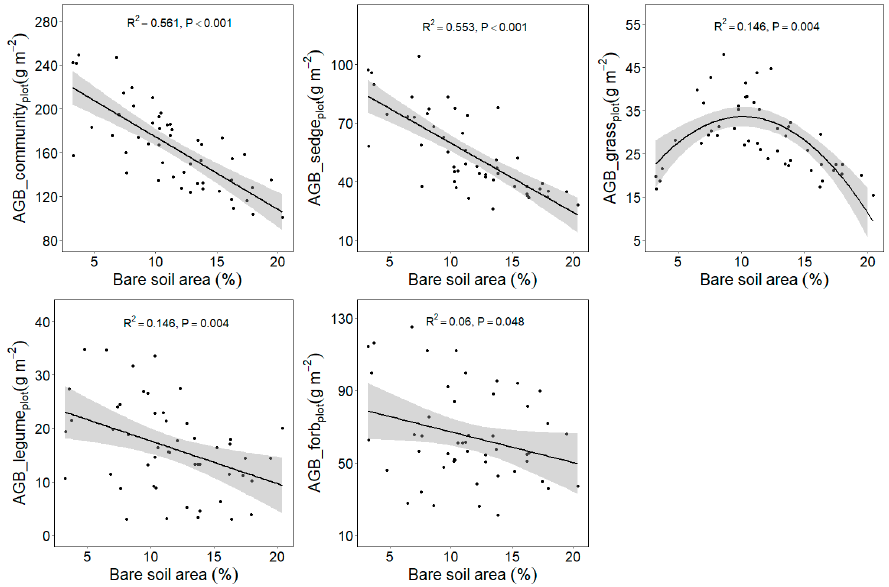
Figure 4. Relationship between plant aboveground biomass at plot scale and the bare soil area (%) in the disturbed plots pika across five sites based on a linear model (LM). AGB, aboveground bio- mass.